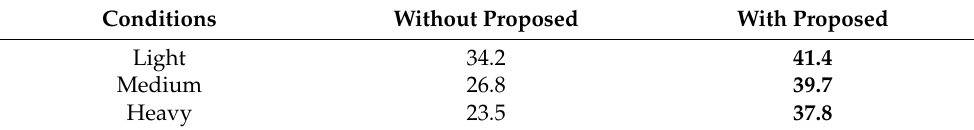
Table 3. Average detection precision comparison between YOLOv4 and the proposed algorithm Conditions Without Proposed With Proposed